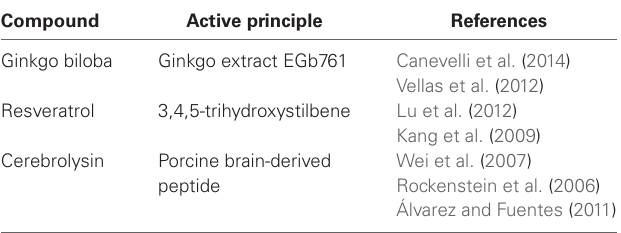
Table 2 | Natural compounds recommended in the treatment